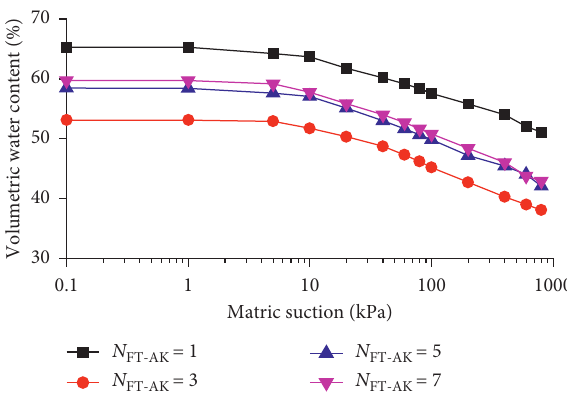
Figure 8: The SWCCs for Ankang expansive soil under different times of the freeze-thaw cycle.